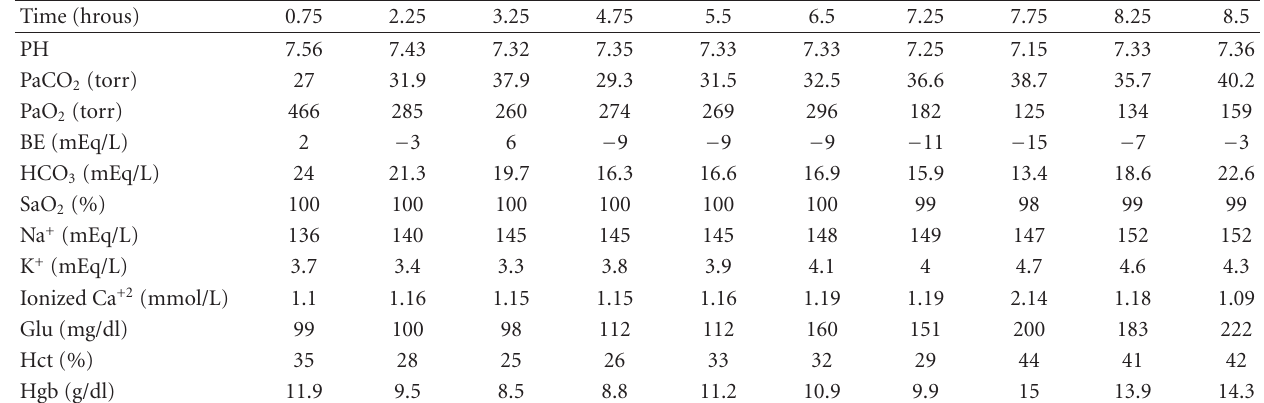
Table 1: Laboratory values over time during surgery. Induction time is zero time.